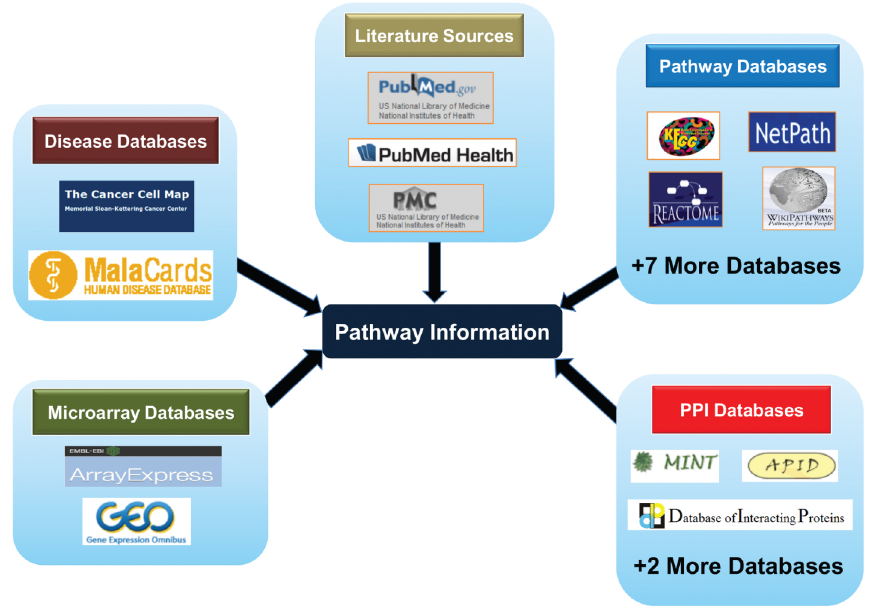
Figure 2: External data sources used to collect pathway information for BIOPYDB In order to build or update the pathways, BIOPYDB uses a specific protocol (see Supplementary File 1)